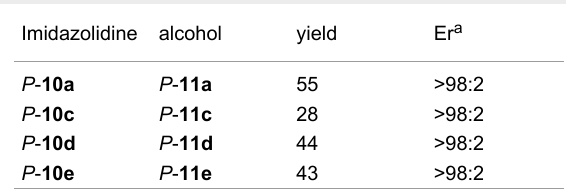
Table 4: Isolation of imidazolidines and hydrolysis/reduction to atropi- someric alcohols 11